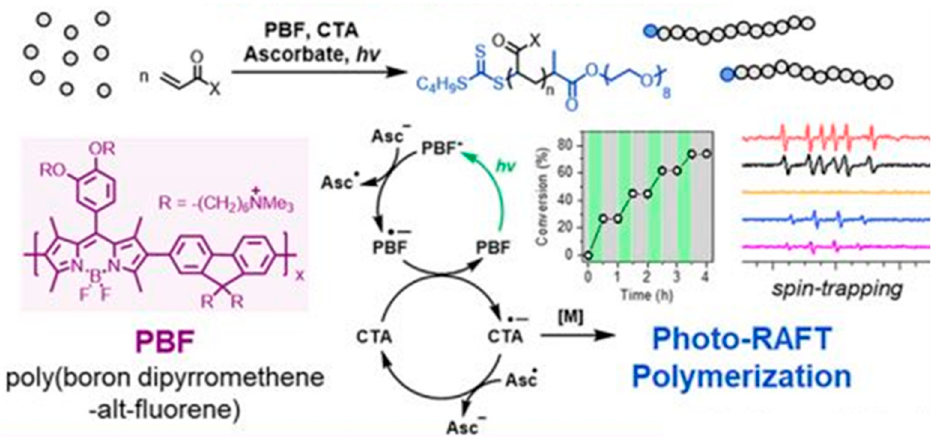
Figure 11. Photo-controlled RAFT polymerization of acrylic monomers, using the conjugated polymer PBF as the photocatalyst [80].